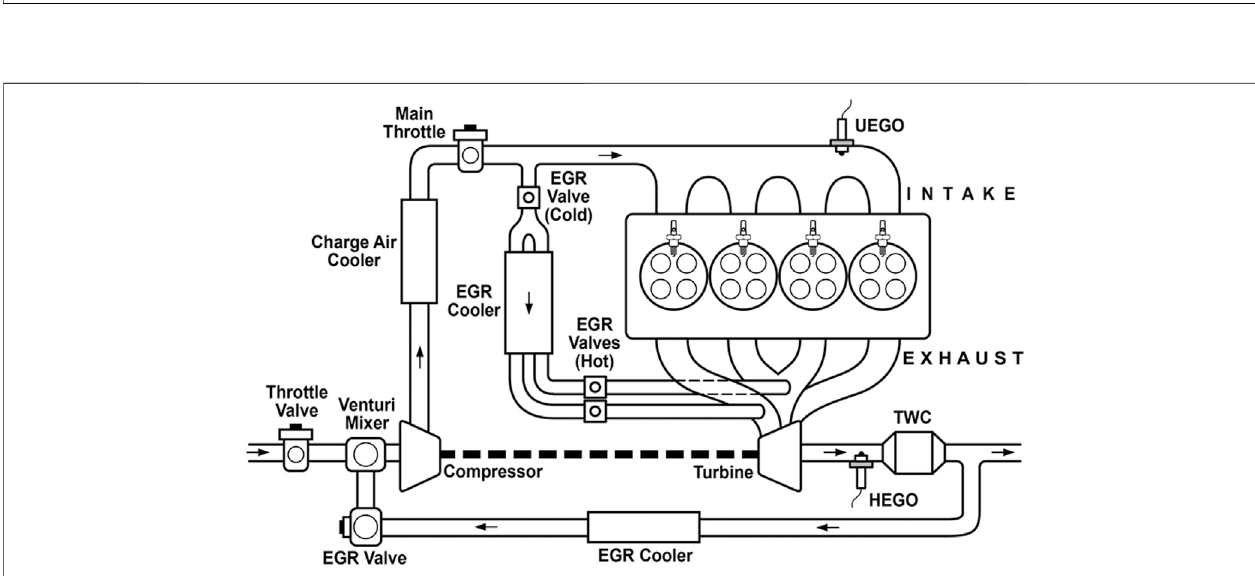
FIGURE 5 | Blended EGR operating points on the (LEFT) Baseline/stock compressor map and the (RIGHT) New compressor ef fi ciency map.